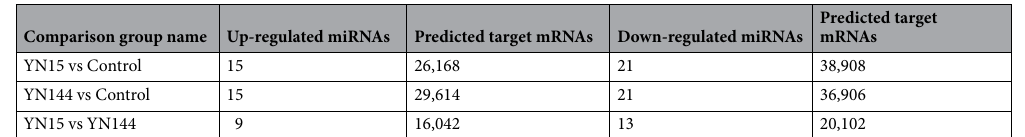
Comparison group name Up-regulated miRNAs Predicted target mRNAs Down-regulated miRNAs